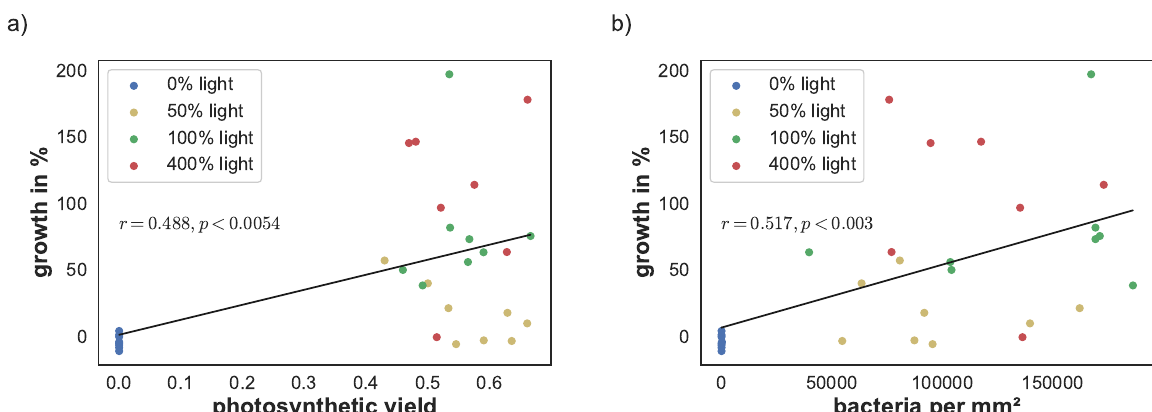
Figure 6. ( a ) Correlation between photosynthetic yield on day 67 and sponge growth and ( b ) correla- tion between cyanobacteria density and sponge